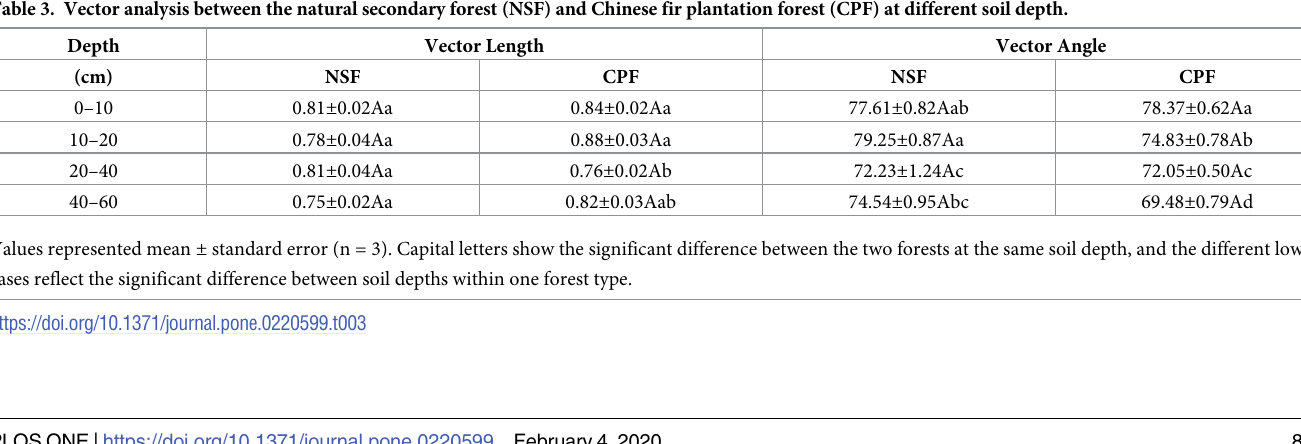
Table 3. Vector analysis between the natural secondary forest (NSF) and Chinese fir plantation forest (CPF) at different soil depth. Depth